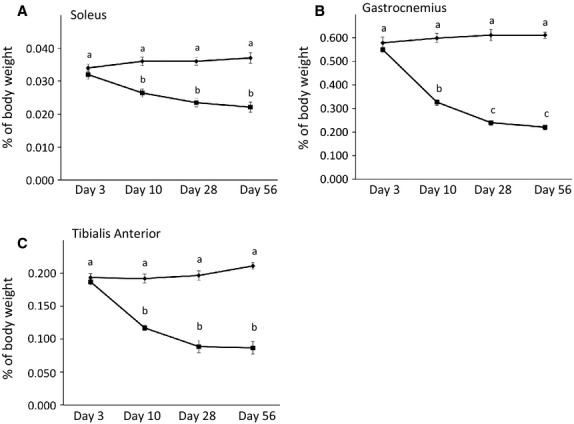
Denervation leads to rapid initial weight loss in hind-limb muscles with no subsequent loss after 28 days post surgery. A. Soleus B. Gastrocnemius C. Tibialis Anterior. Muscle weight is expressed as a percentage of body weight (n = 18 for each). Values are means ± SEM. Different superscripted letters indicate significant pairwise differences between groups following significant time by surgery interaction (ANOVA P < 0.05.